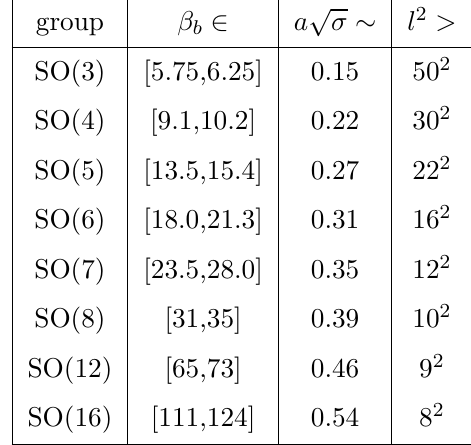
Table 1 . Location (cid:12) = (cid:12) b of bulk transition, with string tension on weak coupling side and smallest useful spatial volume on weak coupling